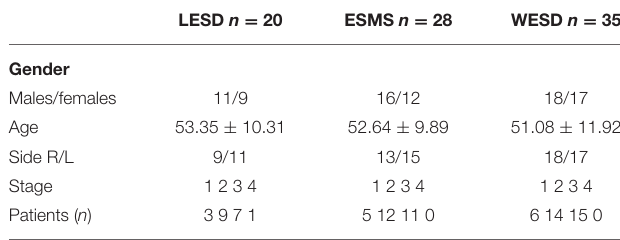
TABLE 1 | Patient characteristics in three